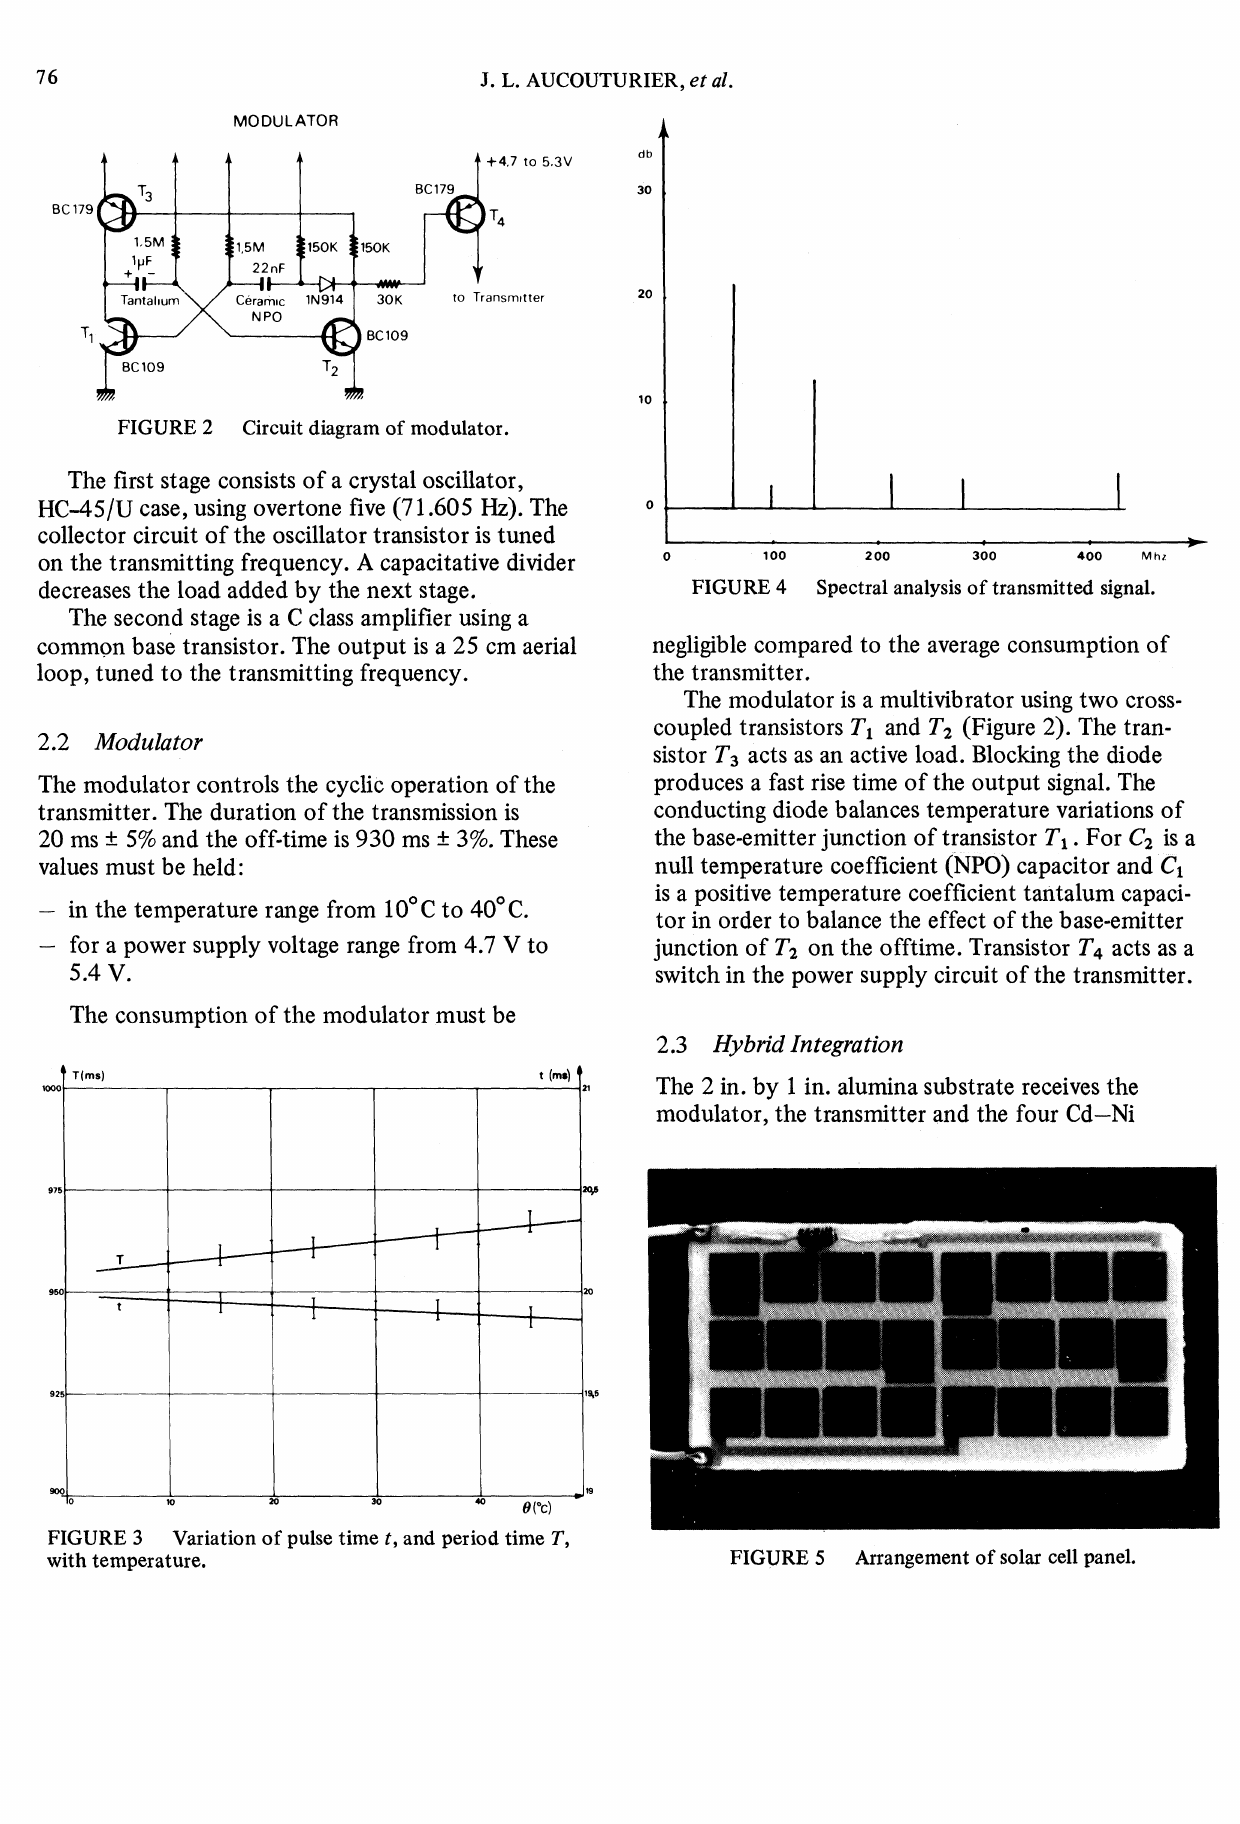
FIGURE 3 Variation of pulse time t, and period time T, with temperature.